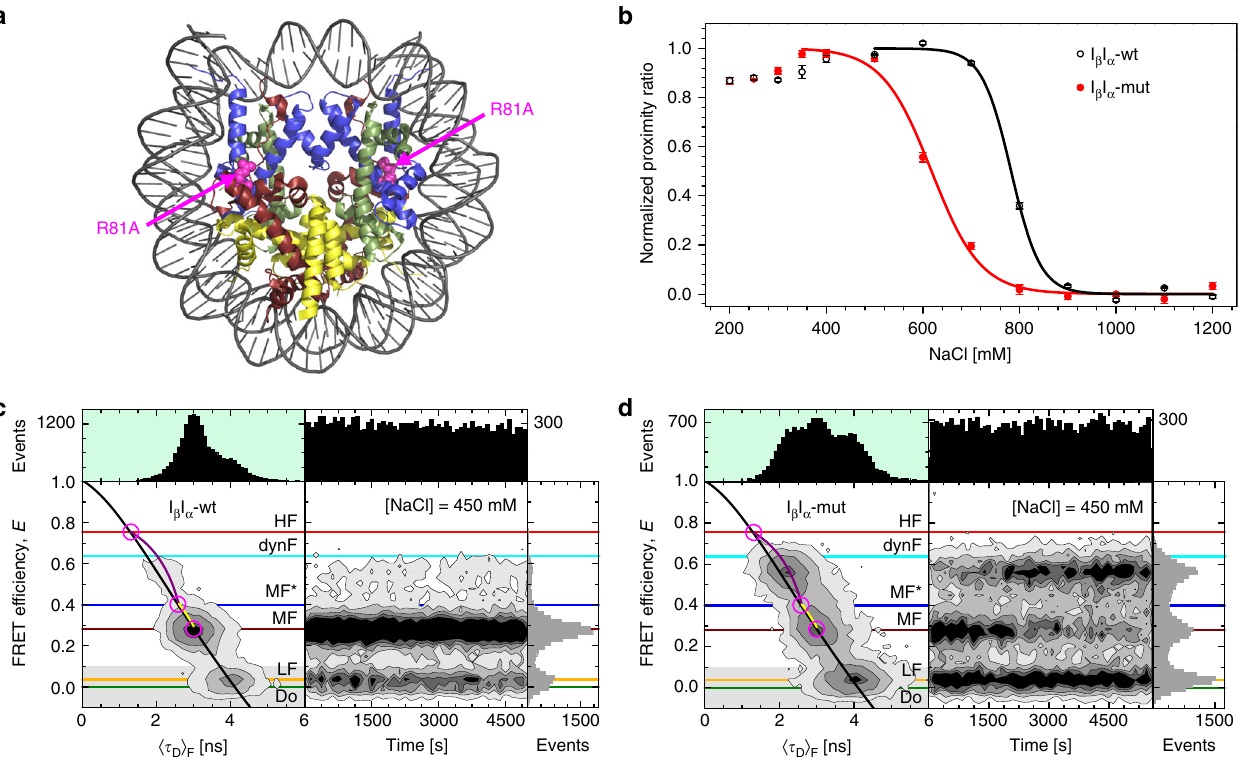
Fig. 6 Effect of the point mutation R81A in H2A on nucleosome dynamics and disassembly. a Crystal structure (3LZ1) with the H2A-R81A mutation (shown in a space fi lling magenta representation) that modi fi es the charge at the dimer:tetramer interface. Histones are shown in blue (H3), pale green (H4), ruby (H2A) and yellow (H2B). b Ensemble FRET analysis of salt-induced disassembly of I β I α -wt and I β I α -mut nucleosomes. Nucleosomes carrying mutated H2A are more susceptible to elevated ionic strength than their non-mutated counterpart; c 1/2 (I β I α -mut) is about 165 mM lower than c 1/2 (I β I α -wt). Average values from 6 independent measurements were: c 1/2 (I β I α -wt) = 783 ± 5 mM and c 1/2 (I β I α -mut) = 618 ± 7 mM. c MFD-smFRET analysis of 100 pM I β I α -wt nucleosomes at 450 mM NaCl. The majority of nucleosomes are found in MF; all three subspecies (LF, MF and dynF) remained stable over time. d MFD- smFRET analysis of 100 pM I β I α -mut nucleosomes at 450 mM NaCl. Over time, a signi fi cant portion of intact nucleosomes (MF) transit into the dynamic FRET state. The fraction of fully open nucleosomes (LF), however, did not change over time. All colored lines in panels c and d match the lines in Fig. 4a, c. Error bars are standard errors from three